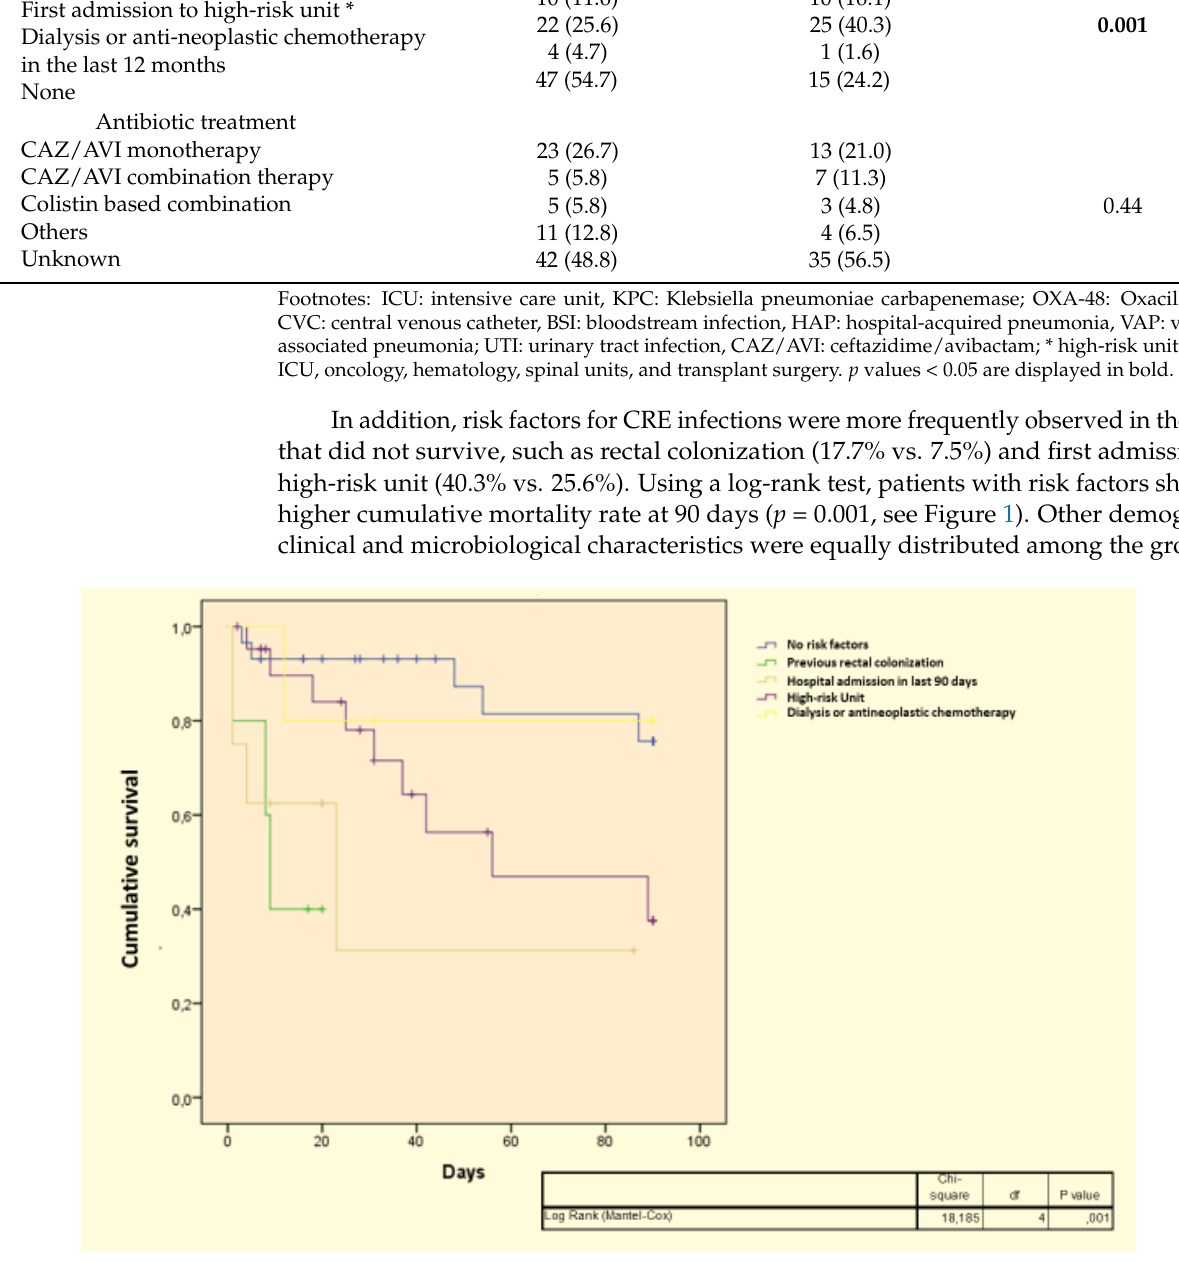
Figure 1. Kaplan – Meier curve on the cumulative mortality rate at 90 days according to risk factors. Figure 1. Kaplan–Meier curve on the cumulative mortality rate at 90 days according to risk 3.5. Independent Predictors of 90-Day Mortality Multivariate logistic regression analysis indicated the presence of at least one risk factor for CRE infection and was the only variable independently associated with mortal- ity at 90 days (OR 2.71, 95% CI 1.21 – 6.07, p value 0.015, see Table 5). Table 5. Independent predictors of 90-day mortality at multivariate logistic regression analysis. OR